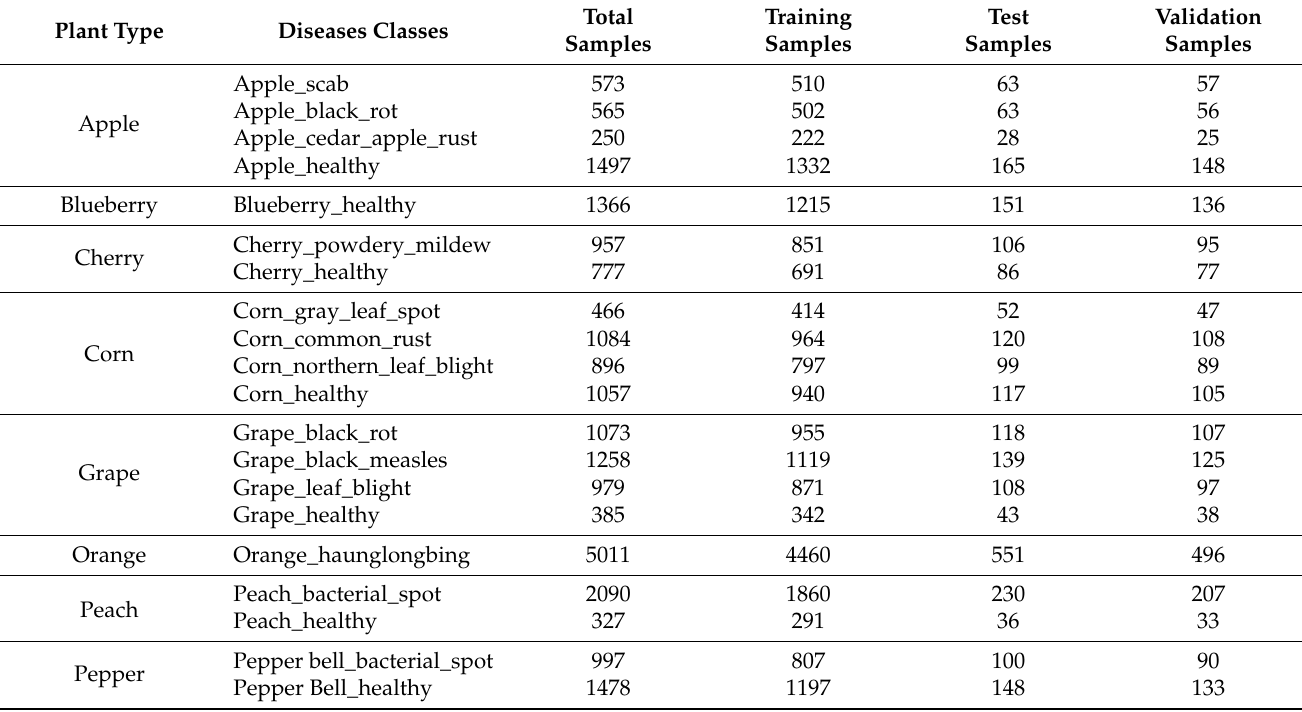
Table 2. Details of PlantVillage dataset split for training, validation, and